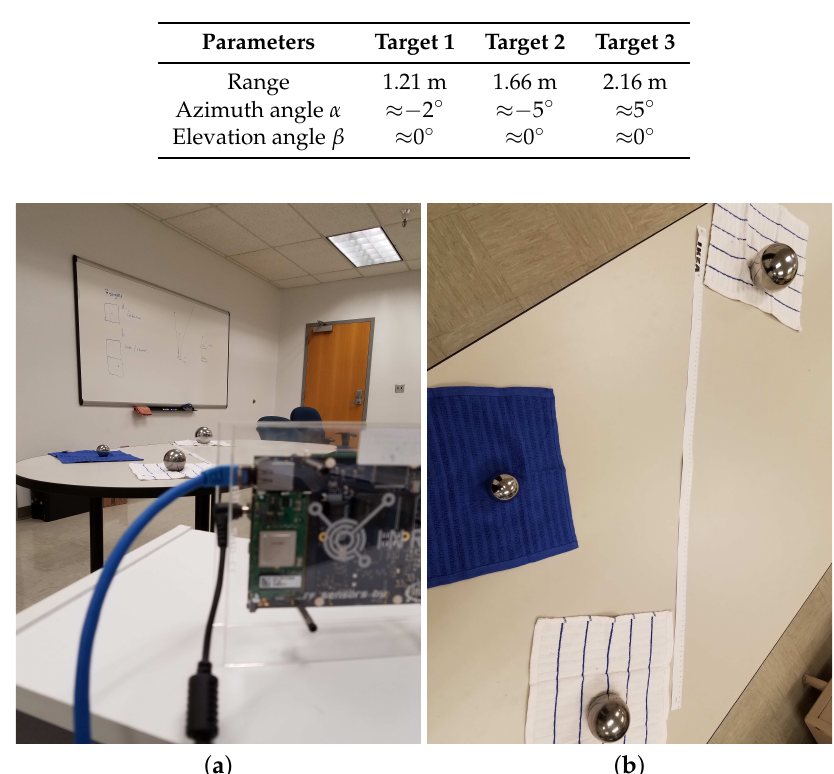
Figure 7. Experiment setup. ( a ) Radar position with antenna facing three ball targets; ( b ) three ball targets’